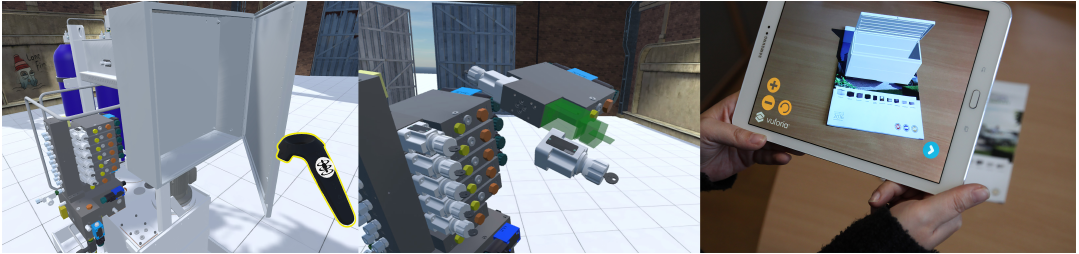
Figure 1. ( Left , Middle ) Virtual Reality (VR) for assembly and disassembly verification; and ( Right ) Mixed Reality (MR)-supported tool showing step-by-step instructions on a